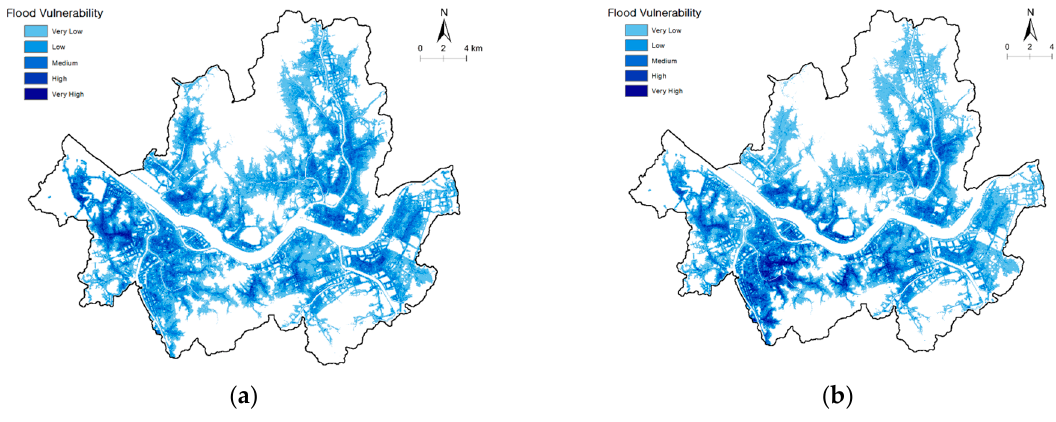
Figure 7. Results of logistic regression (2001): ( a ) Topographic data; ( b ) Topographic and hydrological data.